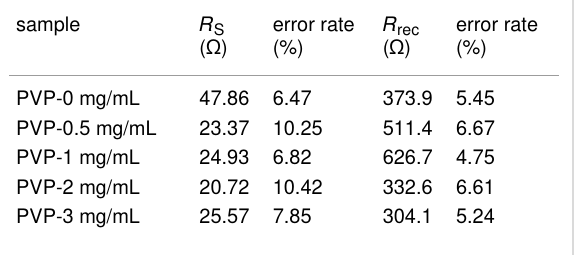
Table 2: Fit results of the Nyquist